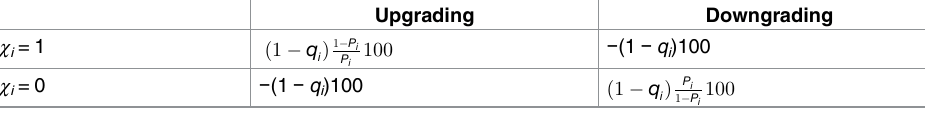
Table 1. Percentage of variation of transition